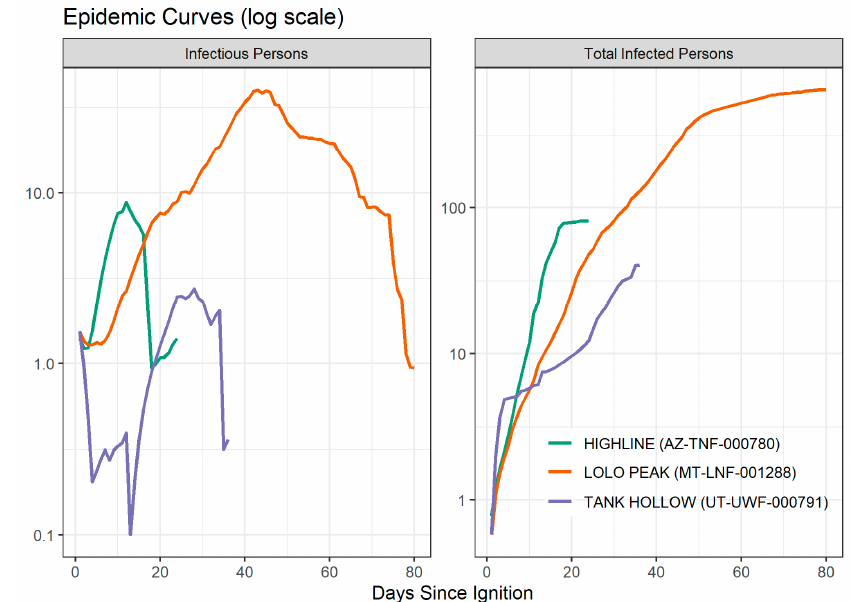
Figure 2. Infectious persons and total infected persons over the duration of each incident, under the baseline scenario. Note that the infectious status is temporary whereas the total number of infections is cumulative. Note that the vertical axis is log scaled.